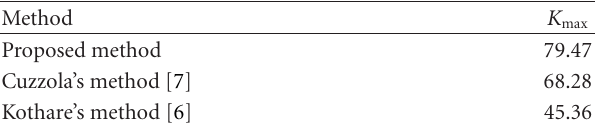
Table 2: Upper bound values of K max